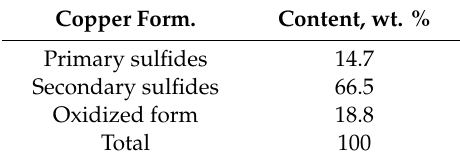
Table 2. Copper distribution in initial low-grade copper–silver concentrate, by minerals. Copper form.